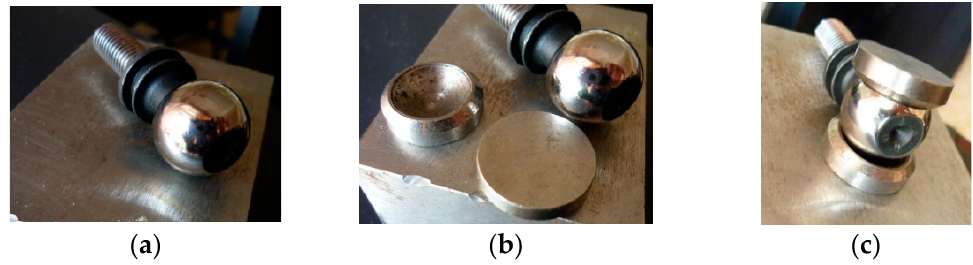
Figure 8. The bipod contact between the centers of spheres from the element 3 (the intermediate part between the shafts 1 and 2) and the symmetry plane of the channel. The higher pairs are de- noted 𝑐 (cid:2869) and the revolute pairs are denoted 𝑐 (cid:2873) .